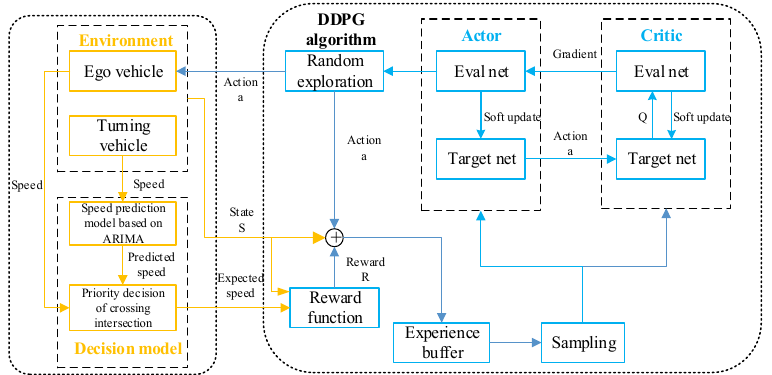
Figure 12. The flowchart of decision-and-control model at intersection based on RL and speed prediction by ARIMA.